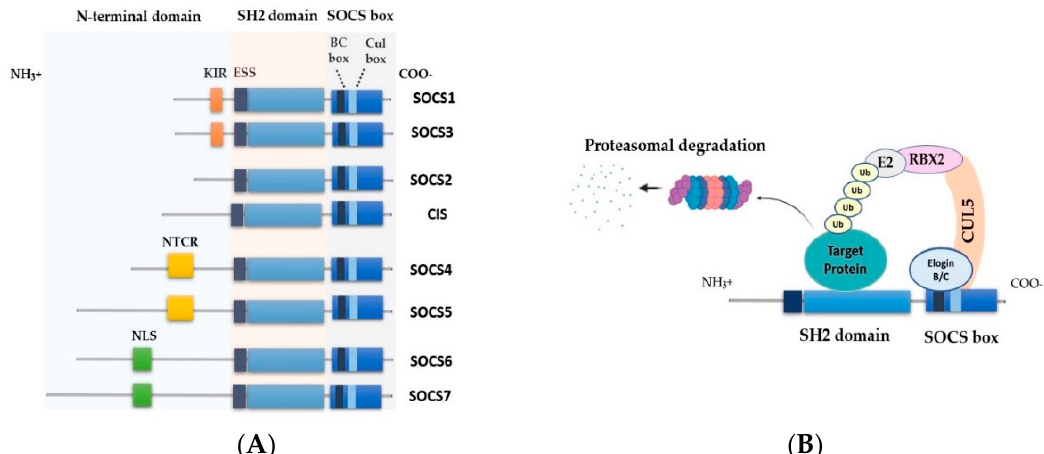
Figure 2. The structure and function of SOCS proteins. ( A ) The eight SOCS proteins contain a variable N-terminal domain, a central SH2 domain, an extended SH2 subdomain (ESS), and a C-terminal SOCS box. SOCS1 and SOCS3 have a kinase inhibitory region (KIR) that acts as a pseudosubstrate for JAKs and blocks their activity. SOCS4 and SOCS5 have N-terminal conserved regions (NTCR). SOCS6 and SOCS7 N-terminal regions contain putative nuclear localization signals (NLS). SOCS box is constituted of BC box and Cul box subdomains. ( B ) The SOCS box subdomains recruit Elongin B and C, Culin5 (CUL5), RING box protein-2 (RPX2), and other E3 ligase elements to induce ubiquitination of target proteins and their consequent proteasomal degradation.